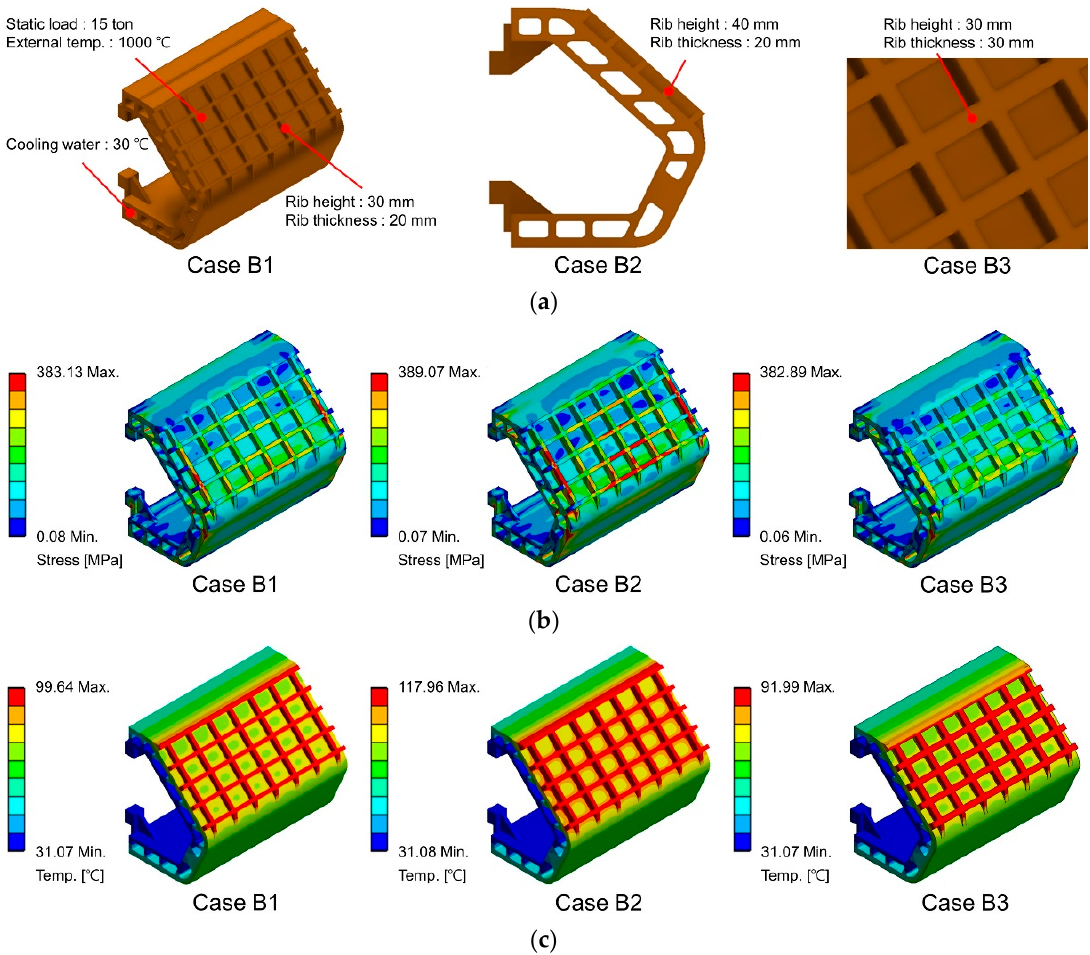
Figure 5. Analysis of protruding water-cooled box for the side-wall injector system with different rib height and thickness: ( a ) analysis condition and case; ( b ) distribution of equivalent (von Mises) stress; ( c ) temperature distribution.